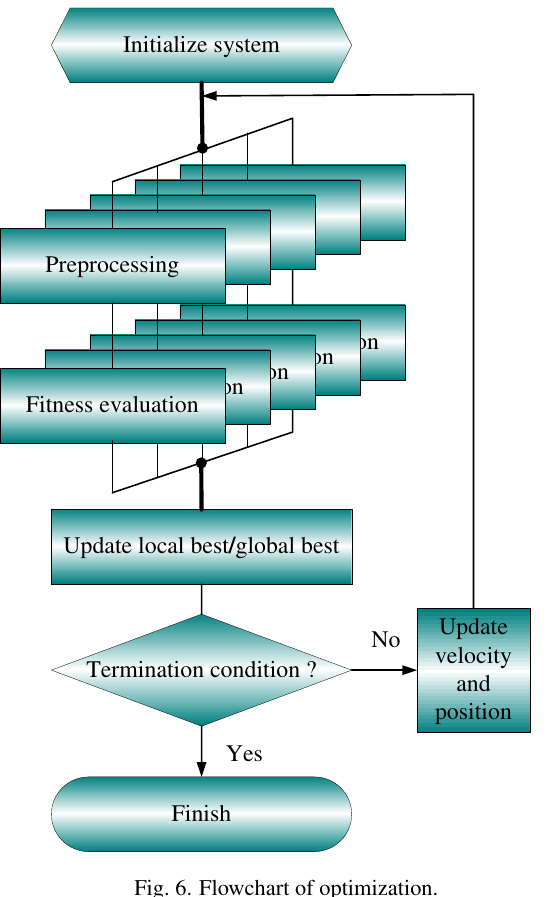
Fig. 6. Flowchart of